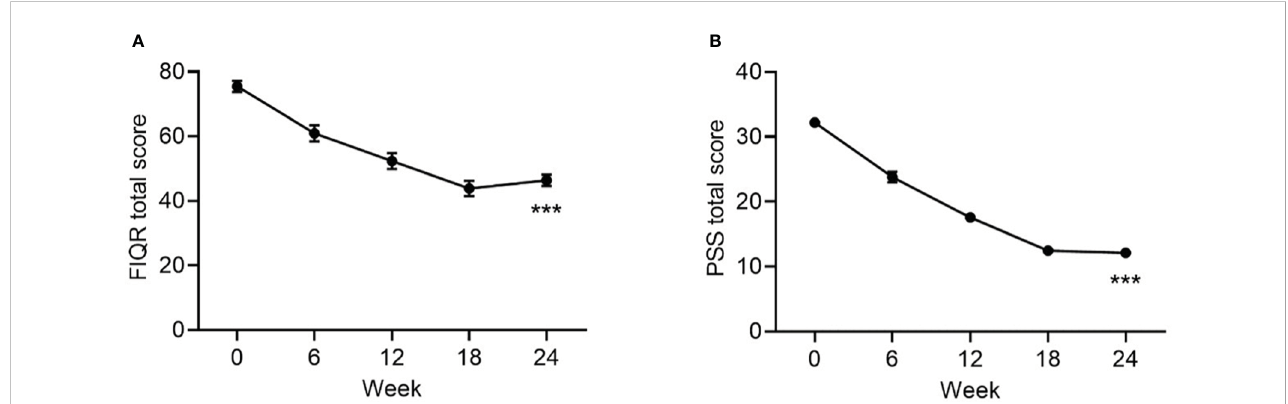
FIGURE 3 Change from baseline to Week 24 in FIQR (A) and PSS Scores. (B) Data are mean ± SE by visit for all participants (N=84). FIQR, Revised Fibromyalgia Impact Questionnaire; PSS, Perceived Stress Scale. ***p<0.001 for baseline vs